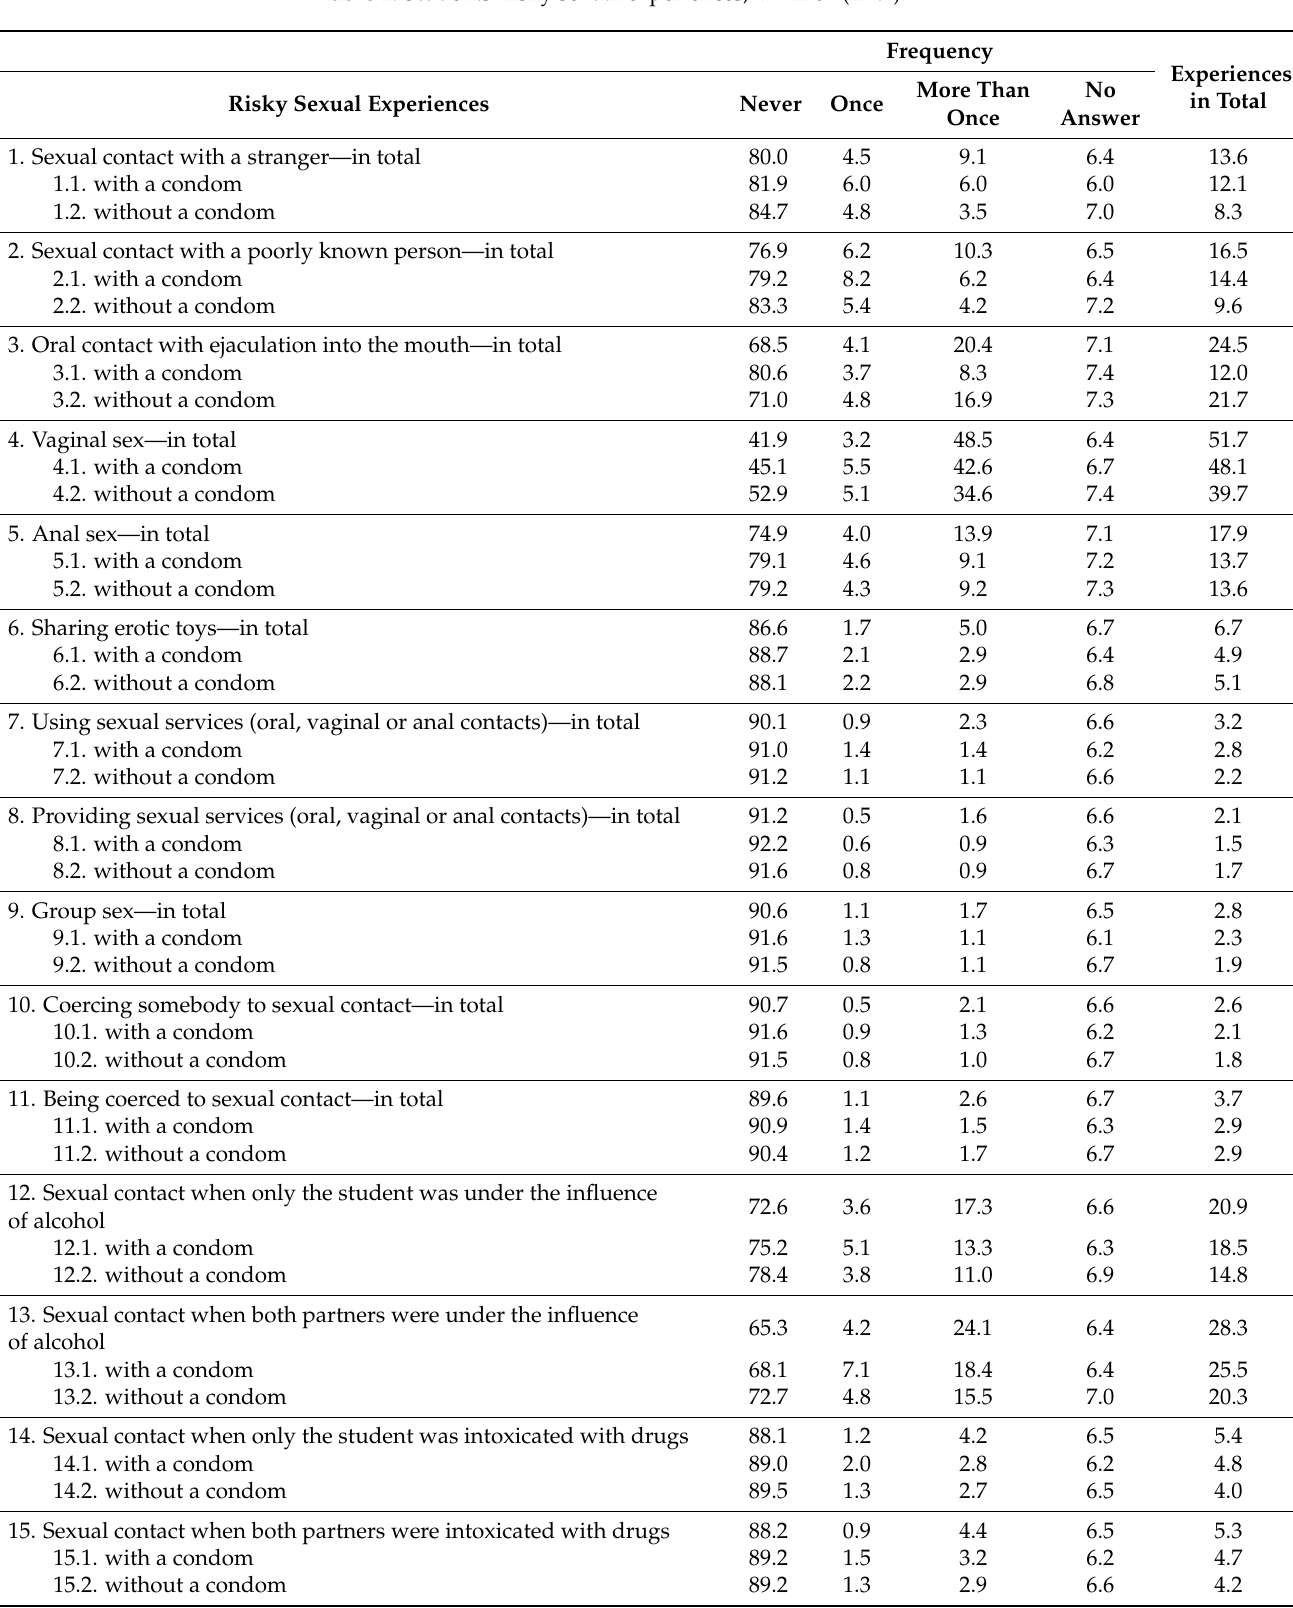
Table 2. Students’ risky sexual experiences, n = 2764 (in